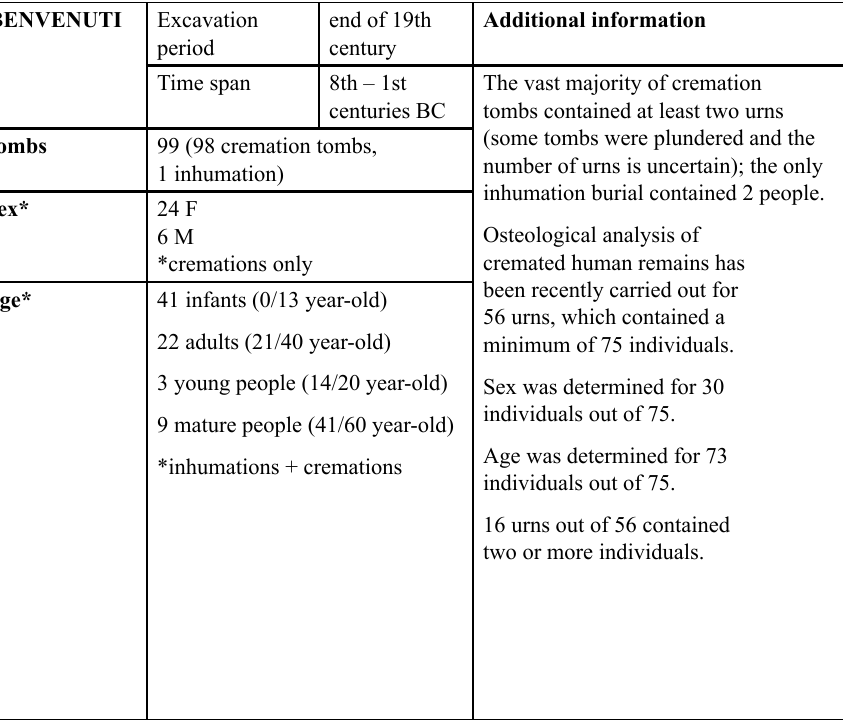
Table 1. Summary of